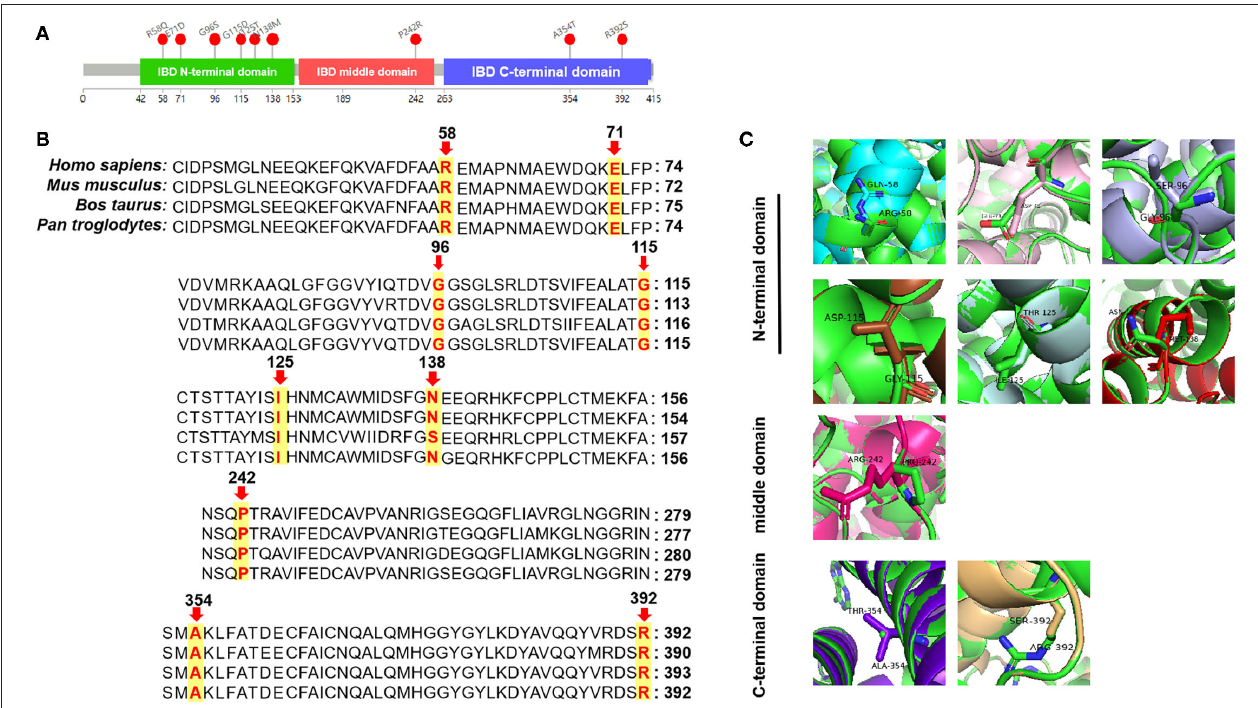
FIGURE 3 | Bioinformatic analyses of ACAD8 -encoded proteins: three-dimensional structural modeling of mutant IBD proteins. (A) Structure of the IBD protein with mutation sites marked. (B) Analysis of amino acid conservation in variant sites among several different species. (C) Swiss modeling of novel IBD protein variants. Arg-58 (Gln colored in cyan), Glu-71 (Asp in pink), Gly-96 (Ser in light blue), Gly-115 (Asp in brown), Ile-125 (Thr in pale cyan), and Asn-138 (Met in red) are located in the N-terminal domain; Pro-242 (Arg in magenta) is located in the middle domain; Ala-354 (Thr in purple) and Arg-392 (Ser in wheat) are located in the C-terminal